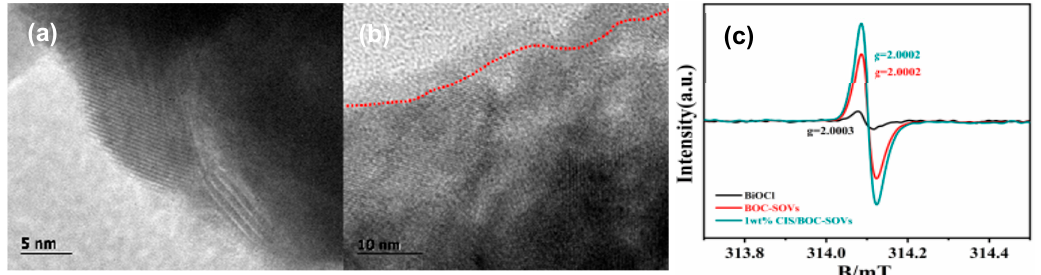
Figure 6. HR-TEM of ( a ) BiOCl and ( b ) BOC-SOVs, ( c ) EPR spectra of BiOCl, BOC-SOVs, and 1% CIS/BOC-SOVs. Table 1. Ratio of OV/OL of the BOC-SOVs sample compared with that of the 1% CIS/BOC-SOVs sample.